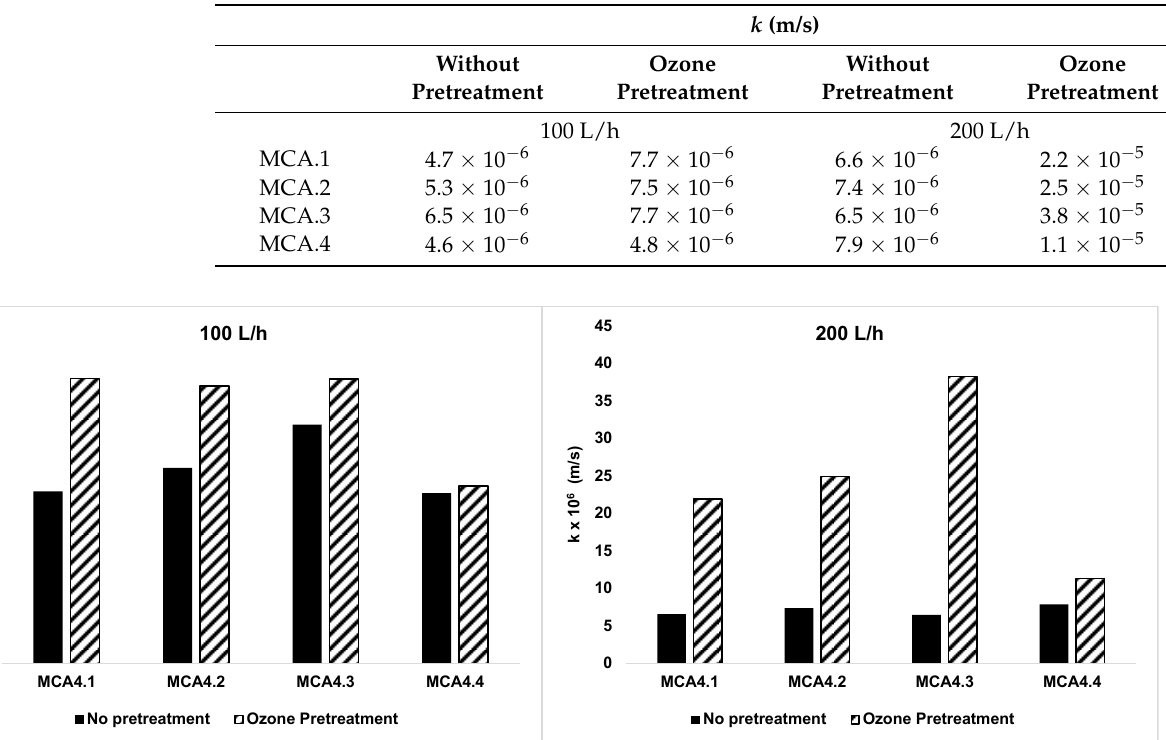
Table 3. Mass transfer coefficient for each membrane, k , feed flowrate, and with or without ozone pretreatment. Figure 2. Representation of ln((1- f )/ f vs. the permeate fluxes in pretreated and non-pretreated effluents for feed flowrates of 100 and 200 L/h.